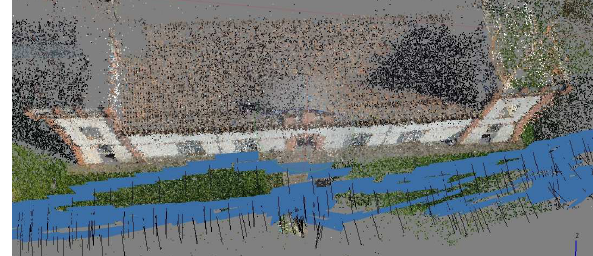
Figure 5: results of alignment process in façade reconstruction